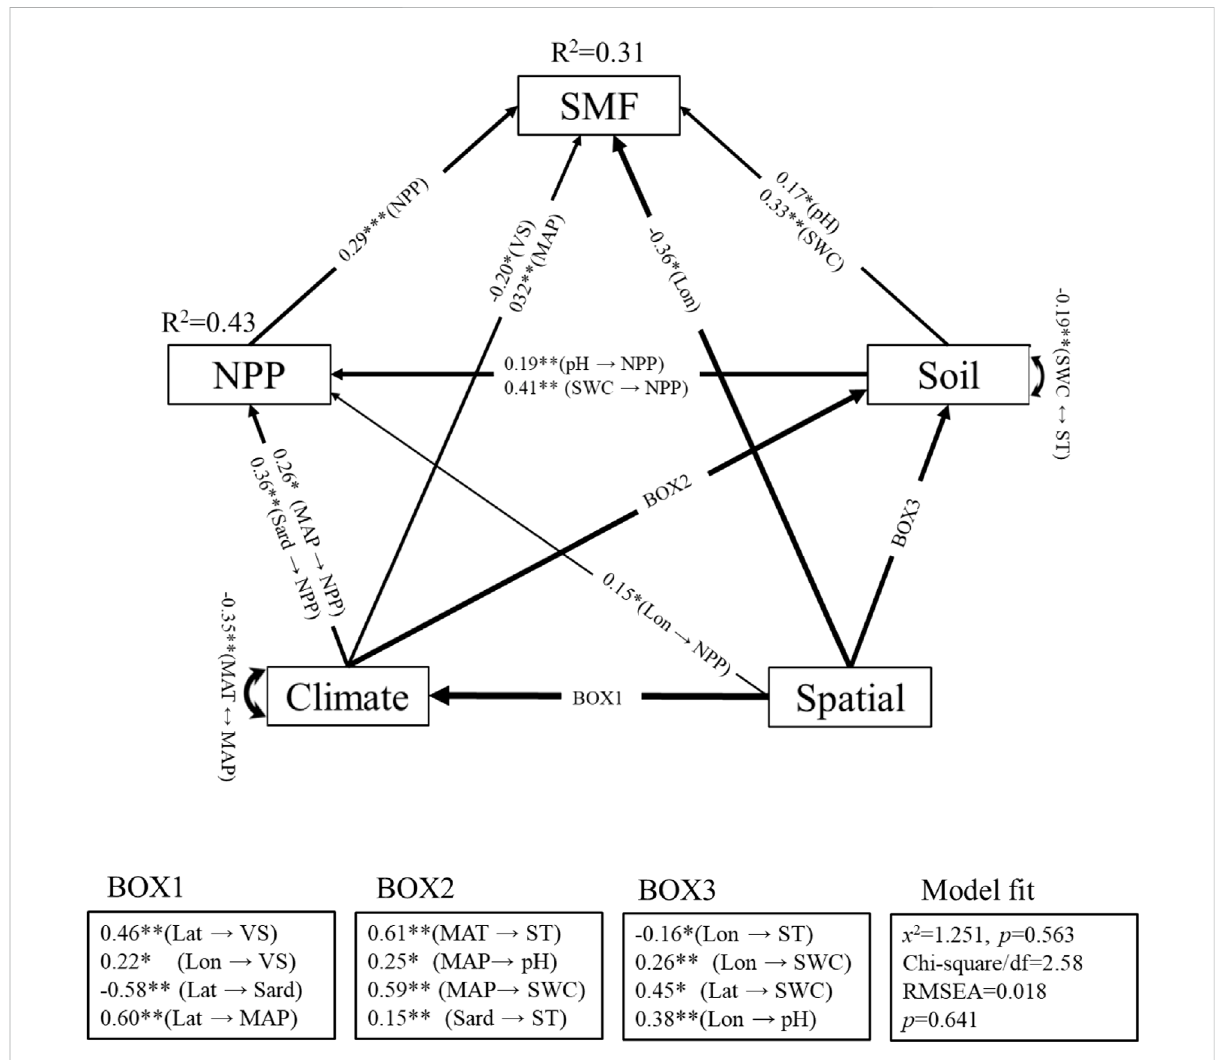
FIGURE 8 Results of the SEM analysis showing the direct and indirect effects of environmental variables on soil multifunctionality. Note: *: p < 0.05; **: p < 0.01; ***: p <